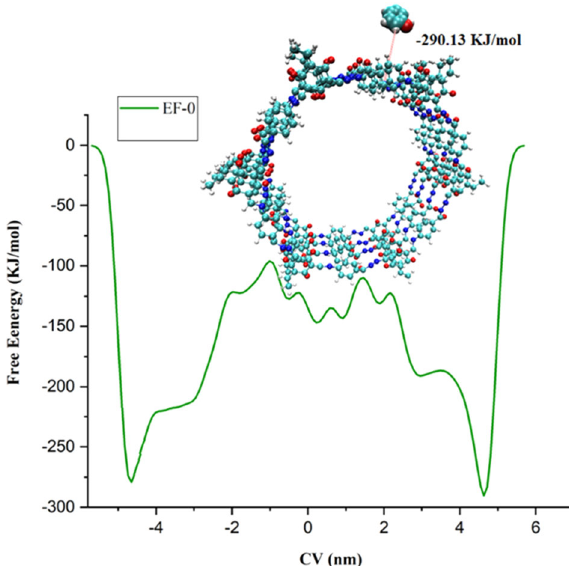
Fig. 7 The free energy pro fi le under zero electrical fi eld condition.